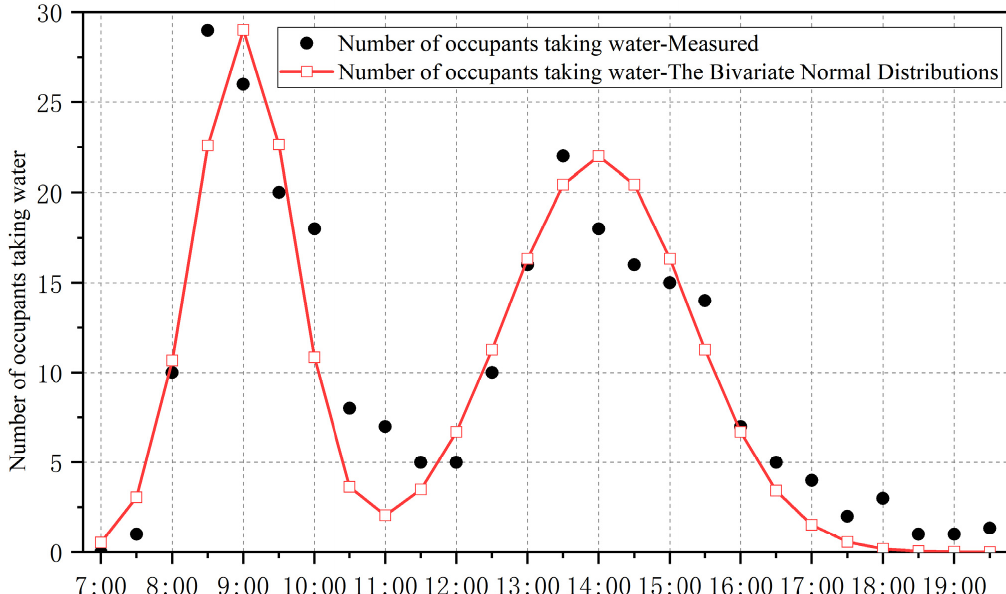
Figure 16. The bi-normal